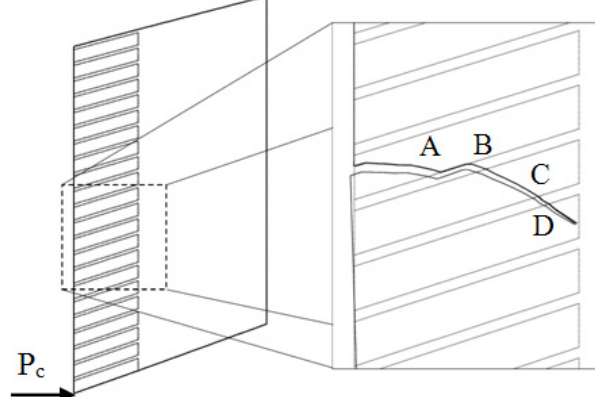
Figure 3: Fracture of a cutter with a cellular microstructure: scheme of the compact bit (left) and magnification of the crack path in the region inside the rectangular dashed box